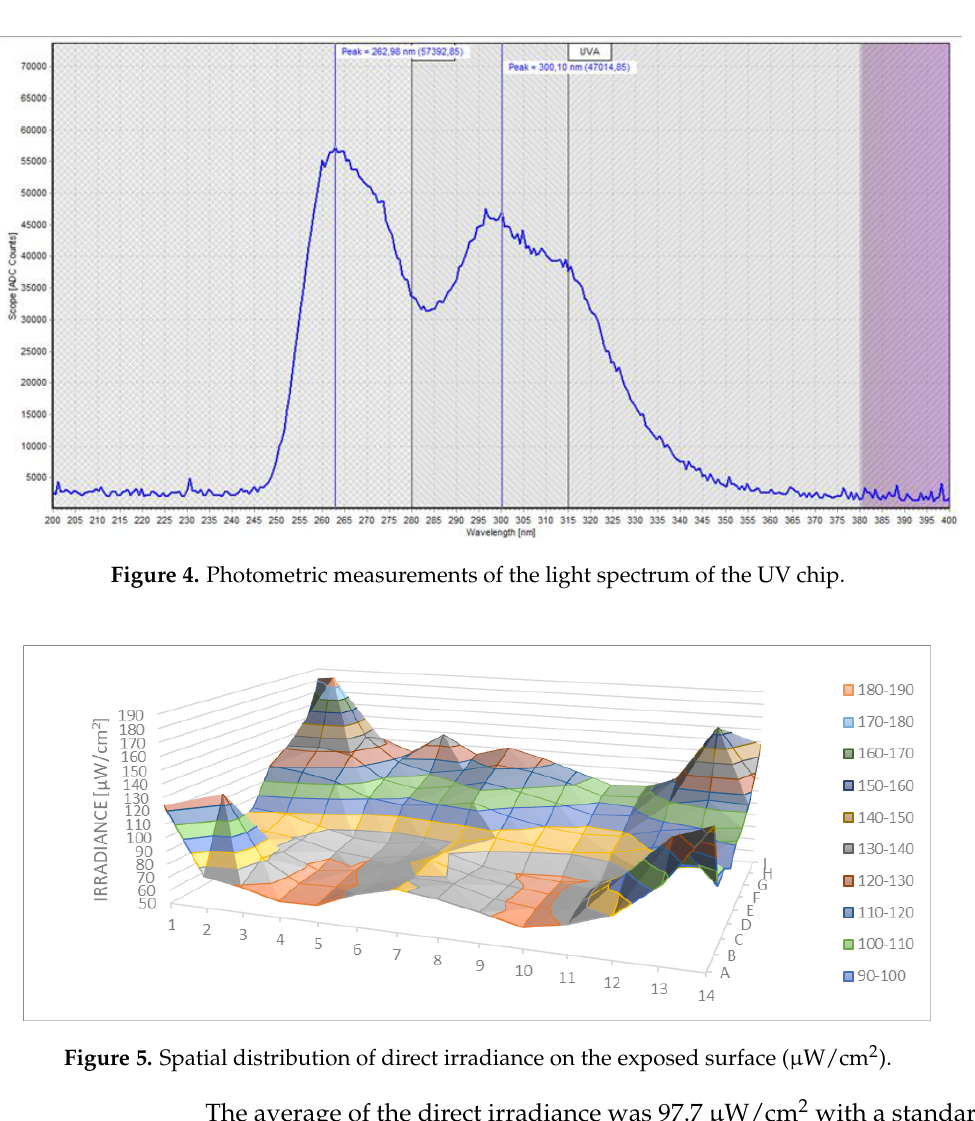
Figure 4. Photometric measurements of the light spectrum of the UV chip .